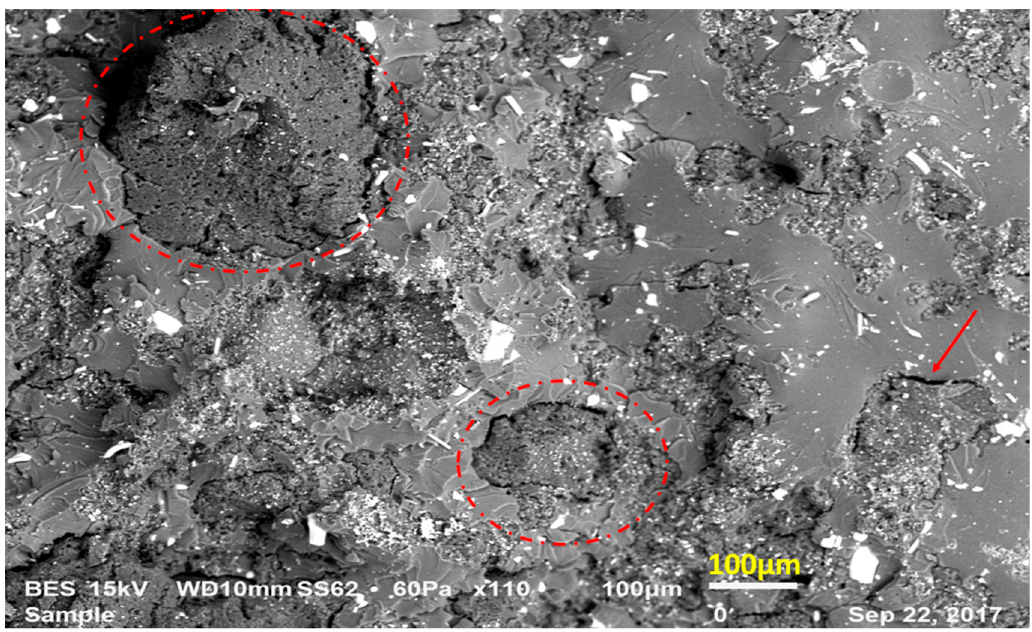
Figure 2. Microscopical observation of the gaps in the epoxy–recycled rubber interfaces.